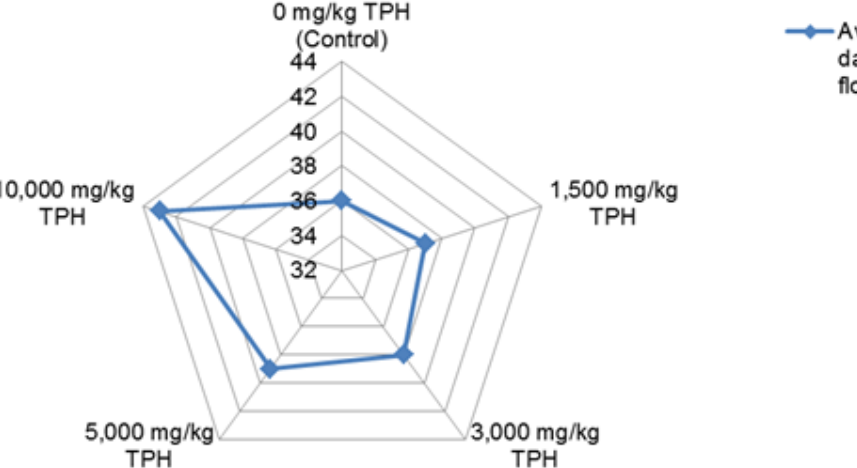
Figure 4. The e ff ect of crude oil contamination on flower production date of B. juncea. Source: Odukoya